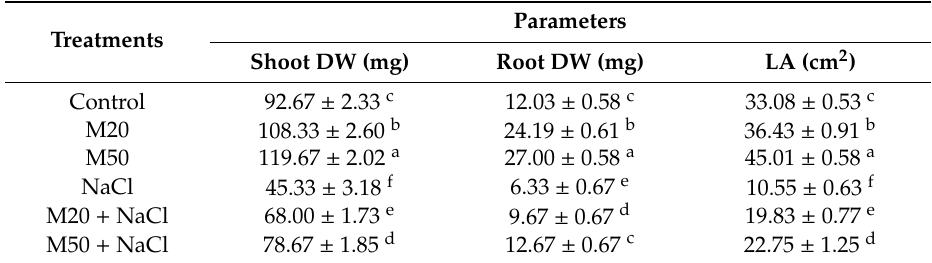
Table 2. E ff ect of melatonin on shoot dry weight (shoot DW), root dry weight (root DW) and leaf area